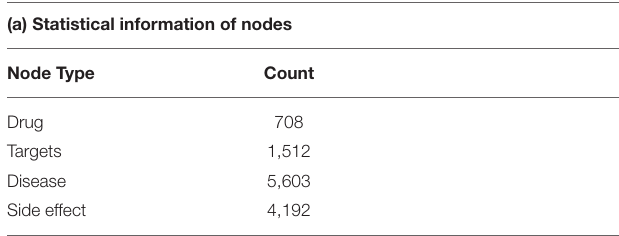
TABLE 1 | Sources of datasets and their statistical information. (a) Statistical information of